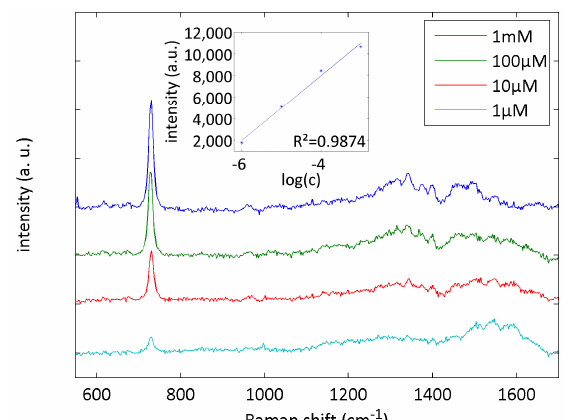
Figure 6. Microfluidic SERS measurements of adenosine solutions at concentrations from 1 µM and 1 mM. Acquisition time was 60 s and we averaged over four randomly chosen spots. The inset shows the linear relation between logarithmic concentration and intensity.